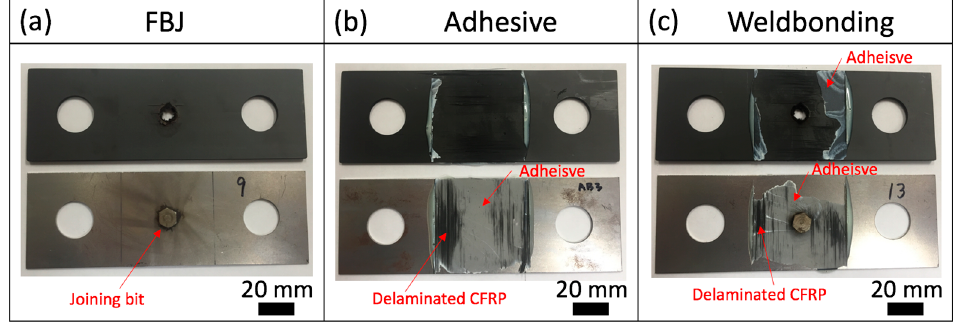
Figure 8. Comparison of fractography for cross-tension-tested specimens: ( a ) FBJ, ( b ) adhesive-bonded, and ( c ) weld-bonded.